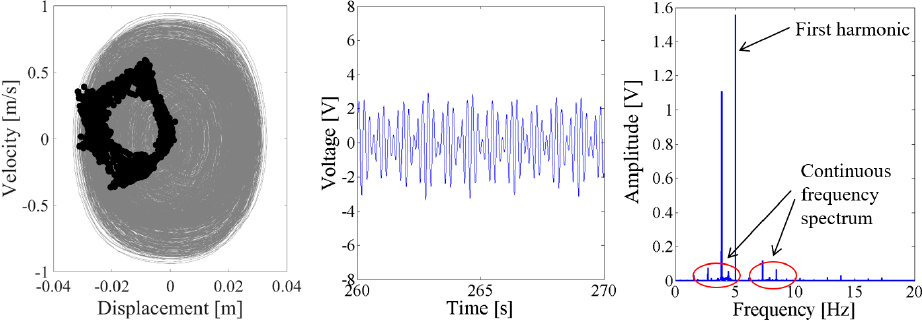
Figure 15. Dynamic responses of the coupled harvester-2 for the excitation level of 0.1 g.